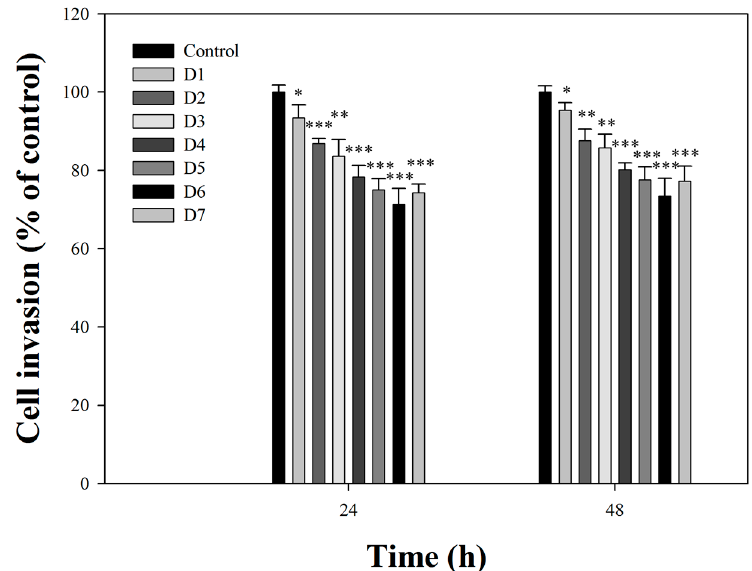
Figure 1. Anti-invasive activity throughout time of incubation of final effluent treated with MFB in SK-Hep-1 cells. Cells (1 × 10 4 ) were incubated for 24 and 48 h with different fermentation time MFB (0–7 days, 10 µg/mL). D1, D2, D3, D4, D5, D6, and D7 represent 1, 2, 3, 4, 5, 6, and 7 days. Values are means ± SD, n = 3; significant difference from control value was indicated * p ≤ 0.05, ** p ≤ 0.01, and *** p ≤ 0.001. Value at the same dose had no significant difference between 24 and 48 h incubation.